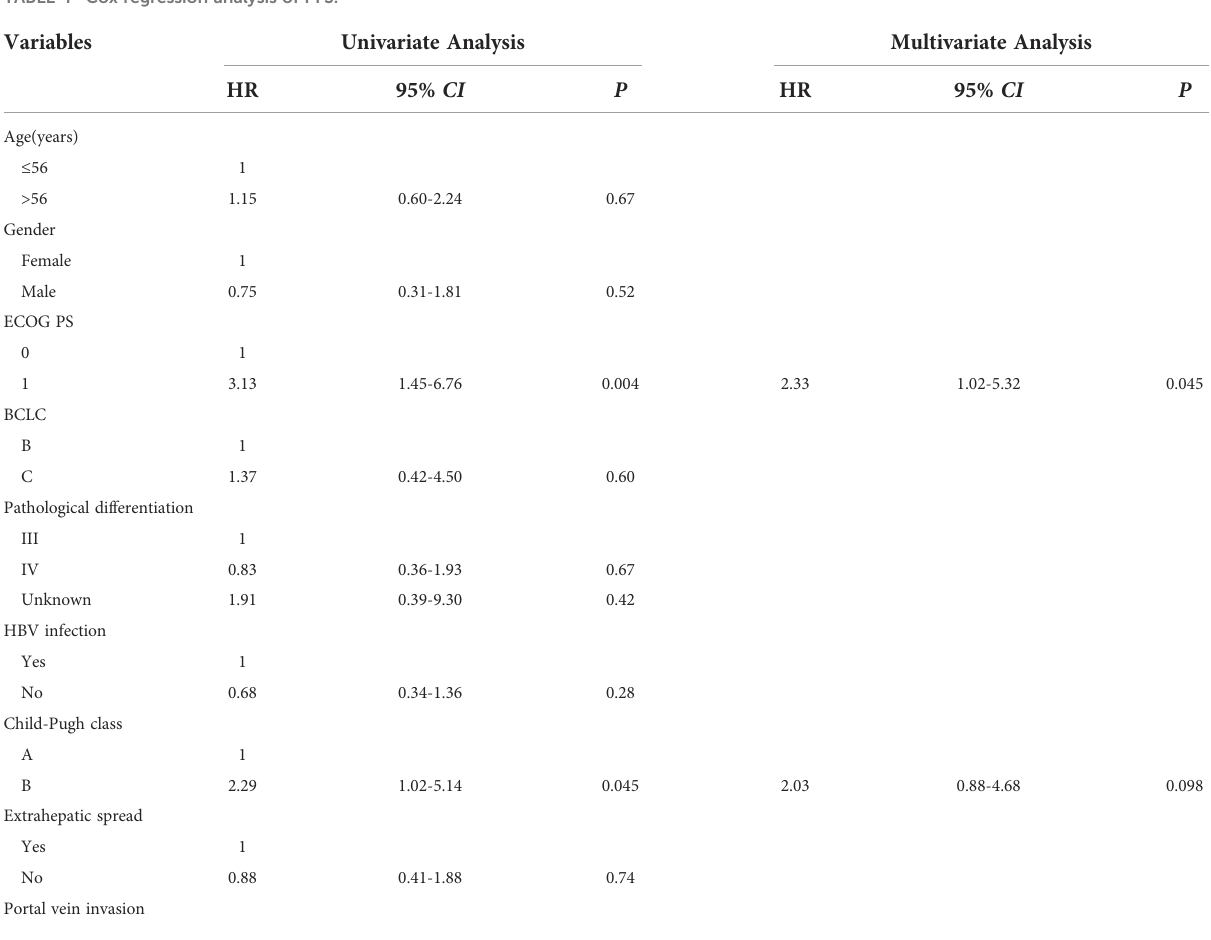
TABLE 4 Cox regression analysis of